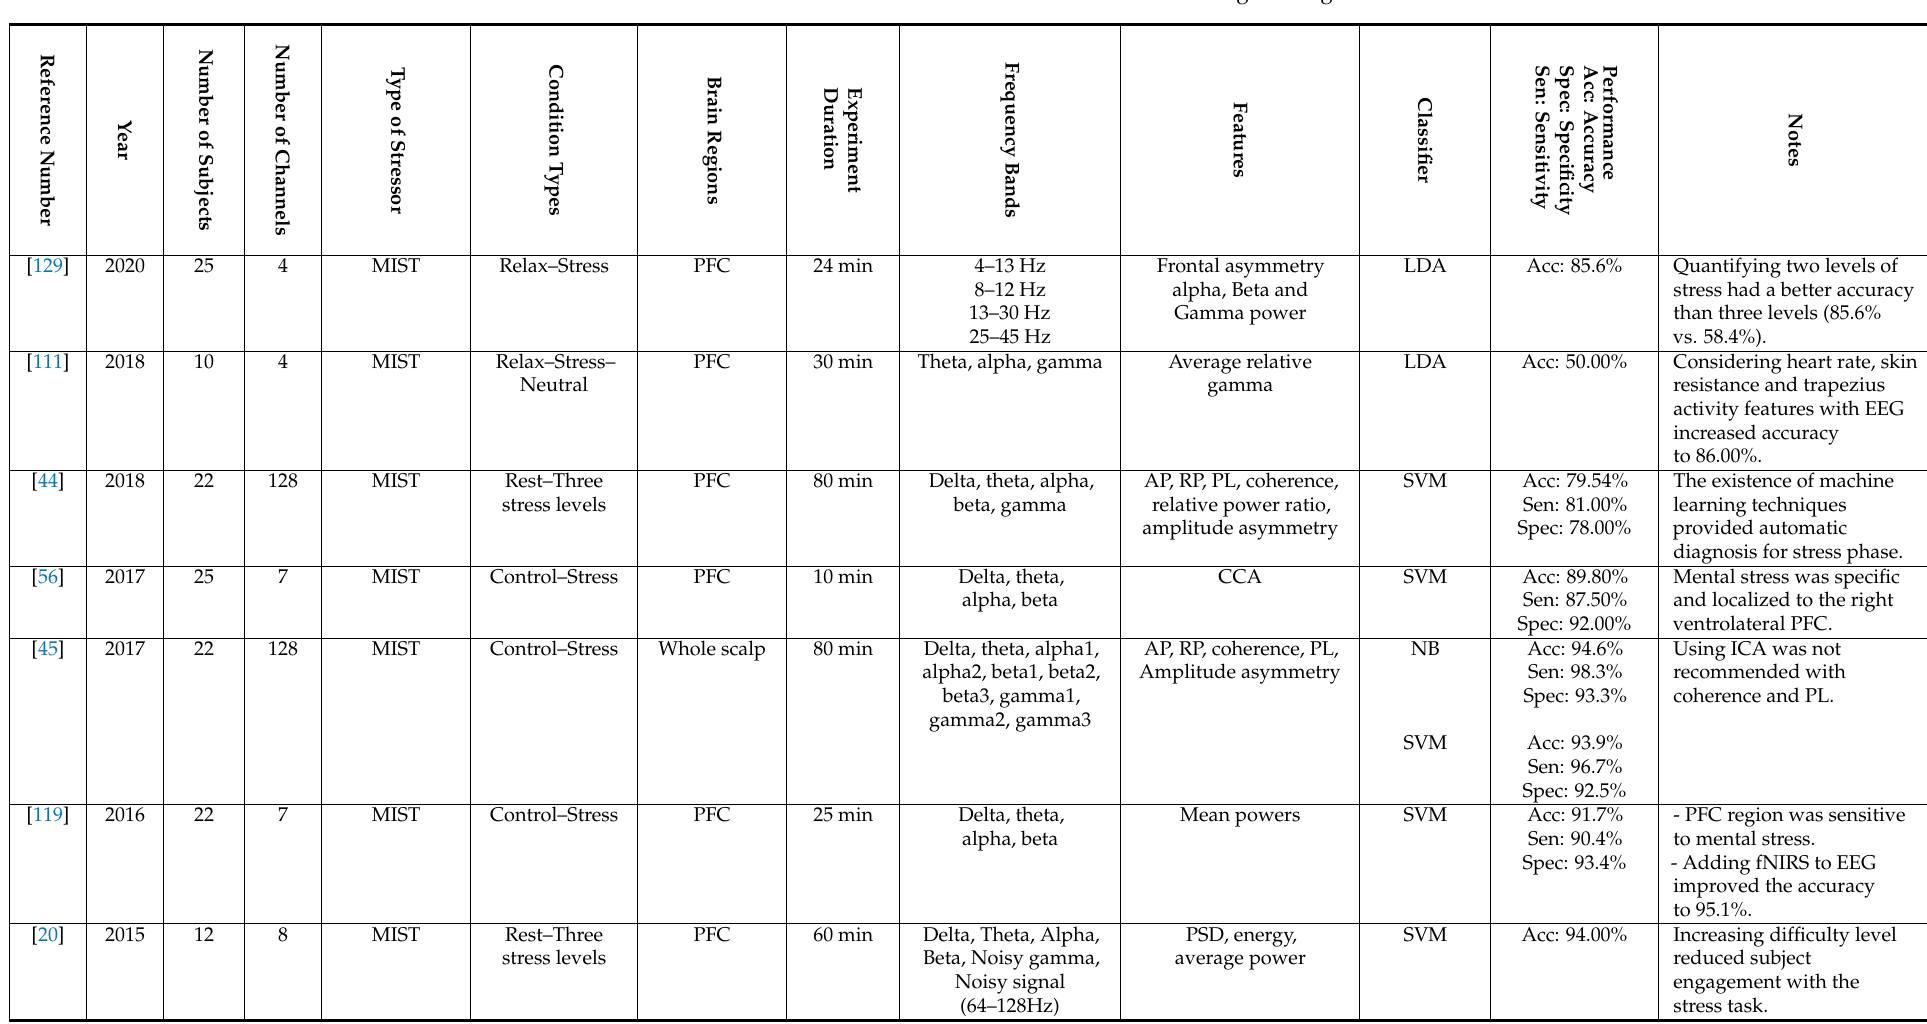
Table 1. Previous studies related to mental stress classification using EEG